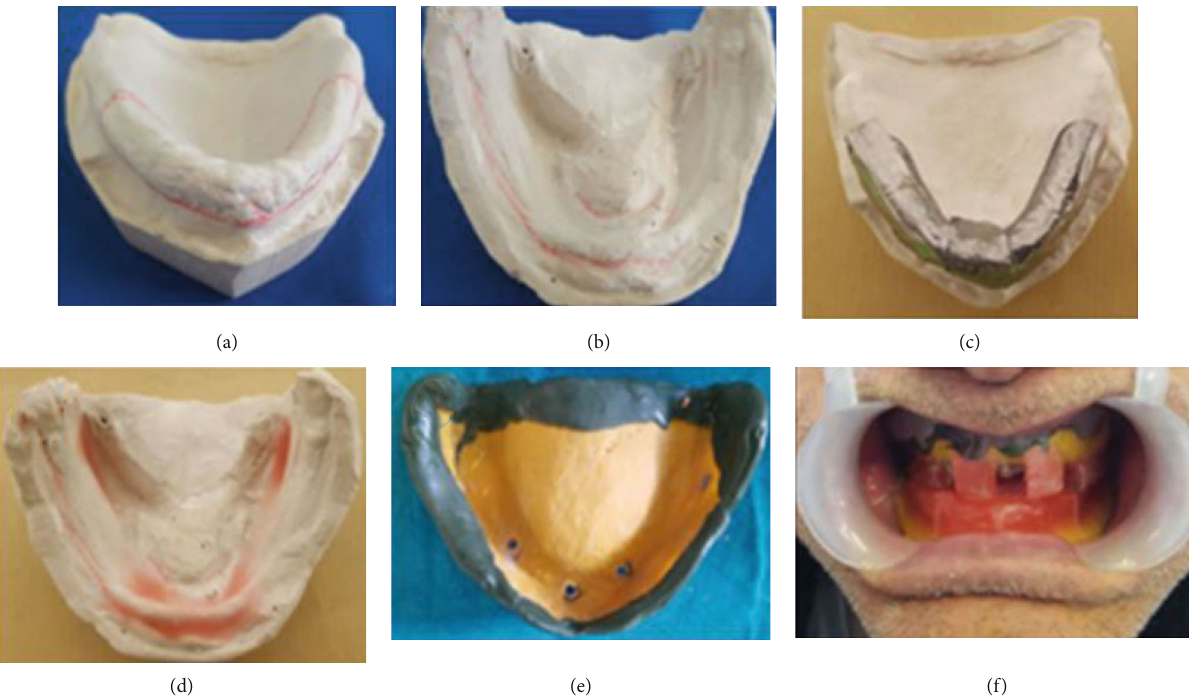
Figure 17: Prerequisites to the fi nal impression. (a, b) The hyperplastic maxillary and mandibular area delineation scribed on the preliminary cast. (c) Dental tin foil over the maxillary hyperplastic area. (d) Blocking out the undercut as well as redundant tissue on the cast with wax. (e) Perforations corresponding to the hyperplastic area. (f) Final impression under occlusal